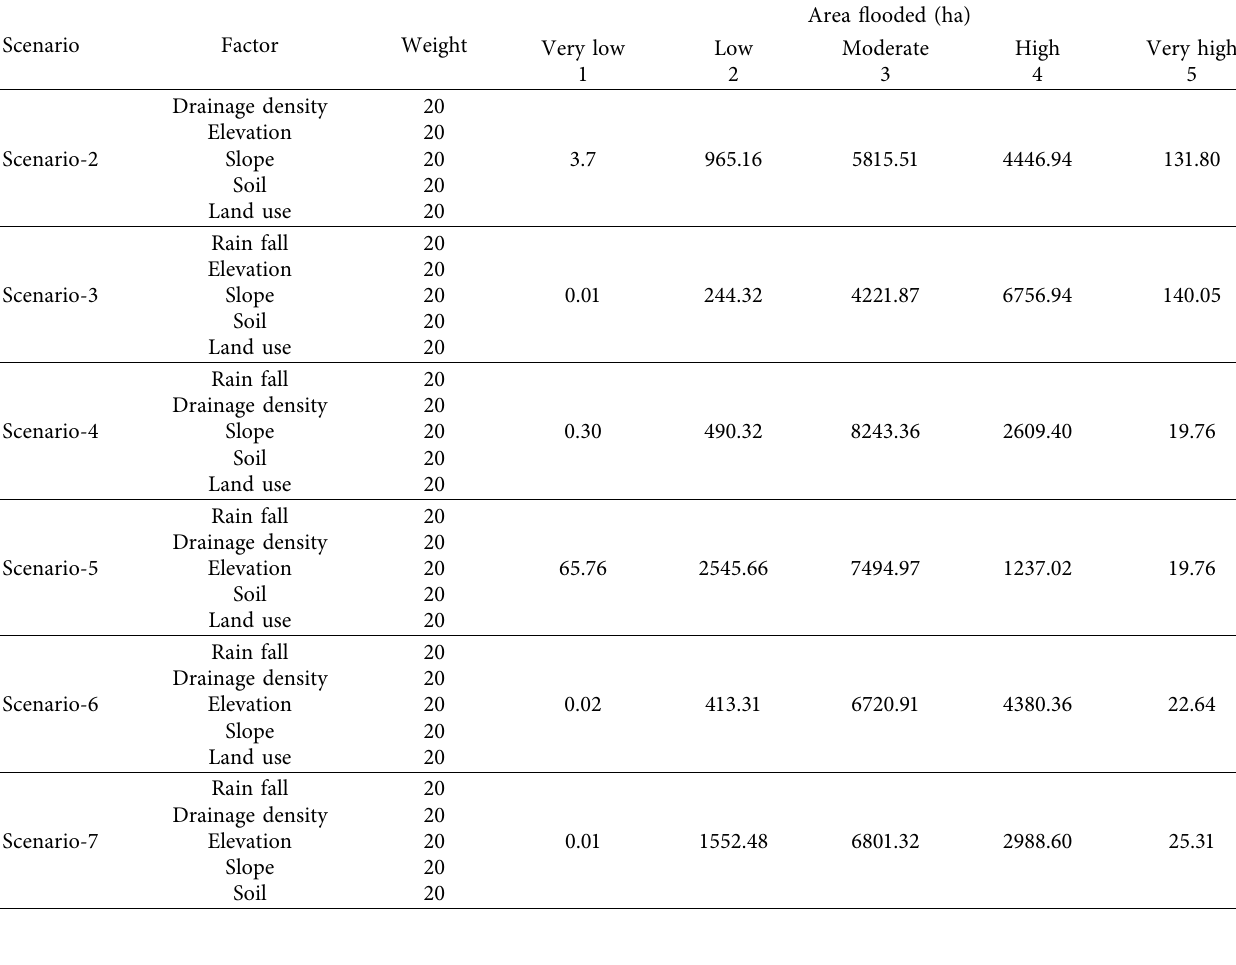
Table 6: Flood hazard area coverages for diferent